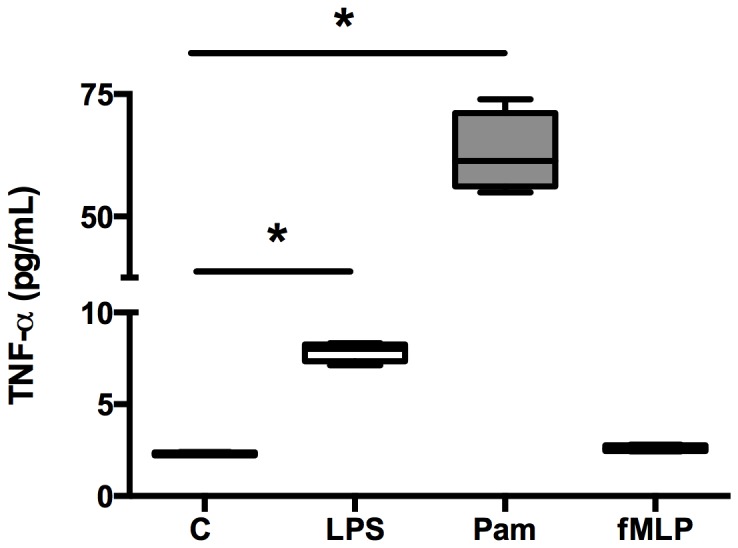

Ex vivo production of tumor necrosis factor alpha (TNF-α) by human neutrophils.The release of TNF-α from non-stimulated (control, C) neutrophils, or LPS- (LPS), Pam3Csk4- (Pam), and fMLP- (fMLP) stimulated neutrophils after 90 minutes were measured with enzyme-linked immunosorbent assay. Boxes represent median (interquartile range). Kruskal-Wallis test with post-hoc analysis by Mann-Whitney test using Bonferroni's corrections were used to compare responses with and without PRRs ligands. *p<0.05. These data are representative of two different experiments.